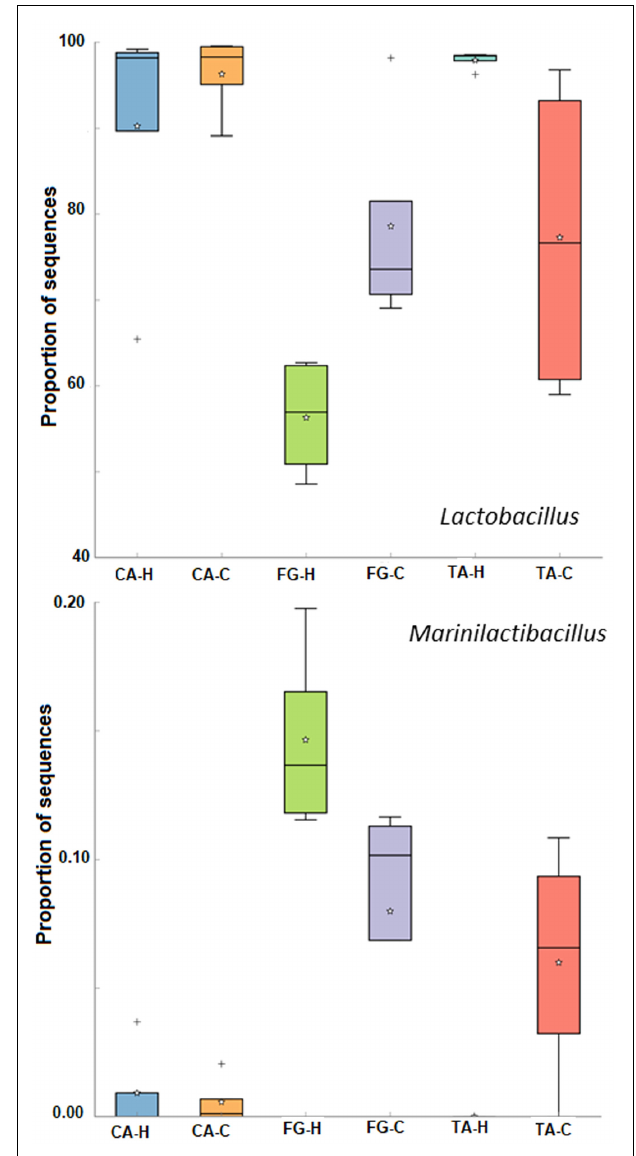
FIGURE 5 | ANOVA Tukey–Kramer post hoc comparison test executed with STAMP v2.0.1 to elucidate significant differents for Lactobacillus (upper panel) and Marinilactibacillus (lower panel) genera in the diverse treatments. Significant differences were only considered for p ≤ 0.05 and a q -value below 0.3. Meaning of symbols: Cross, star and horizontal line inside box denoted for outlier, mean, and median of the percentage of sequences obtained. CA-C, cured control; CA-H, heat-shocked cured olives; FG-C, refrigerated fresh green control; FG-H, heat-shocked refrigerated fresh green olives; TA-C, control of traditional olives; and TA-H, heat-shocked traditional olives. All treatments were applied to the Aloreña de Malaga